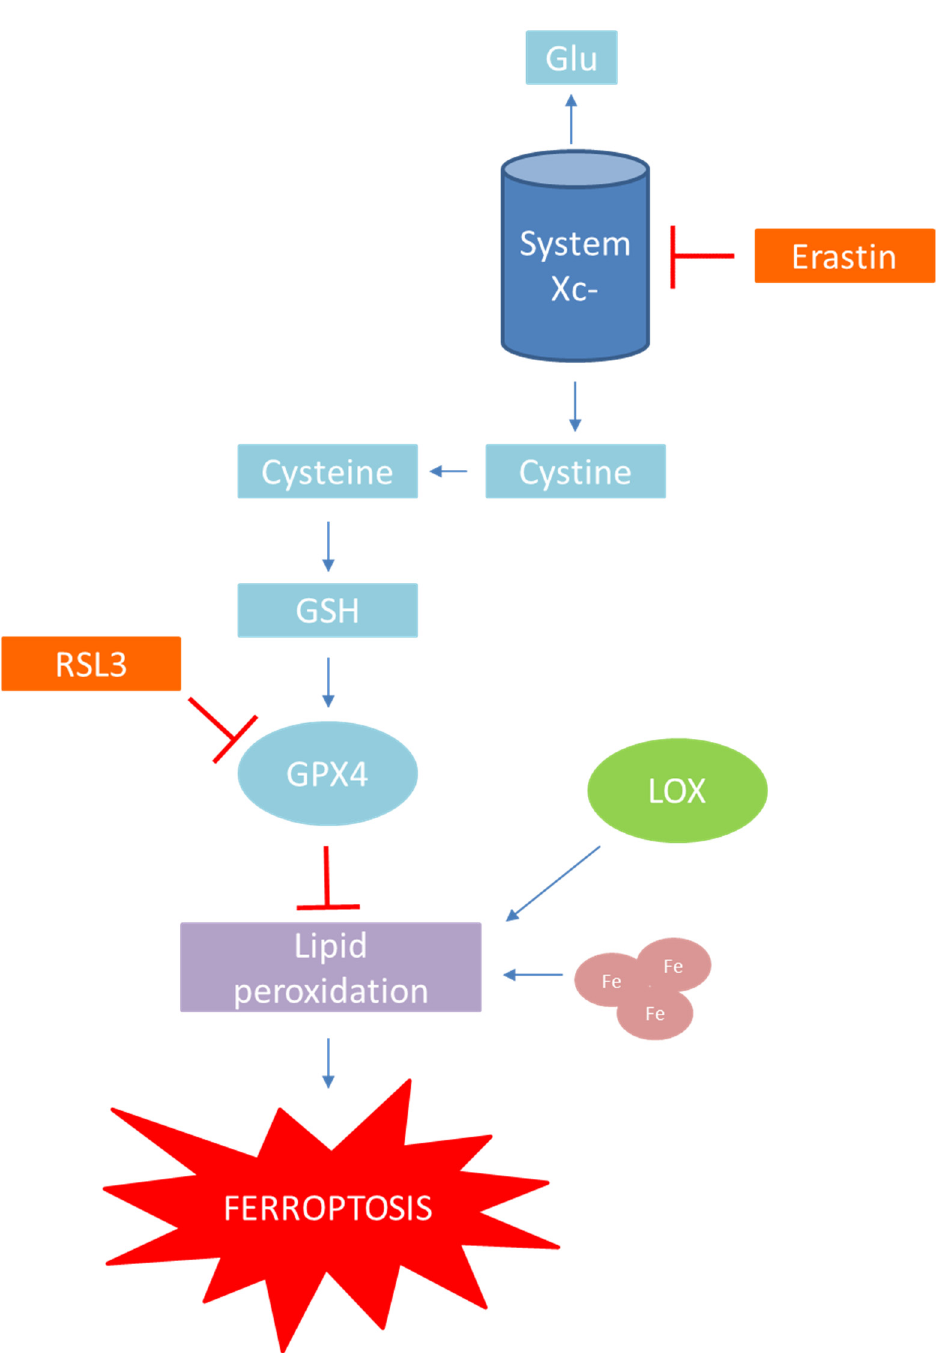
Figure 4. Mechanisms of ferroptosis induction and inhibition.